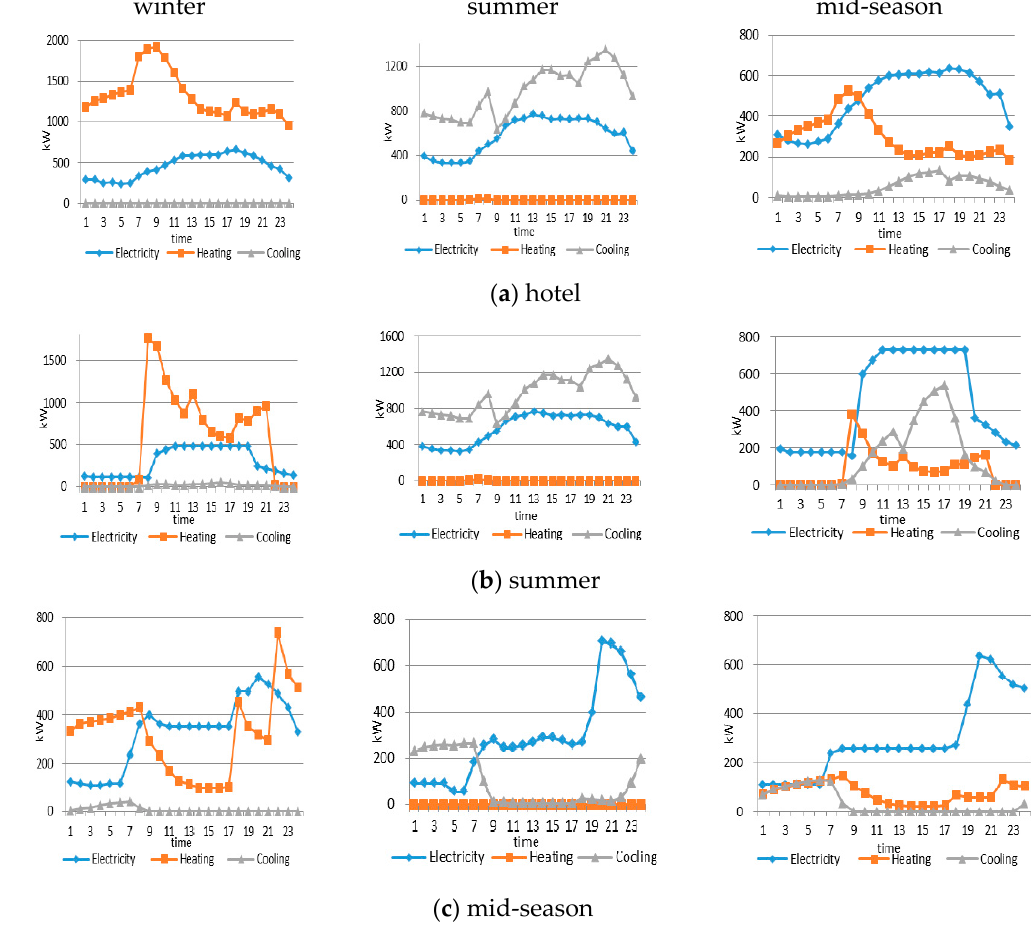
Figure 1. The energy loads of typical buildings of distributed energy system (DES) in respective day.